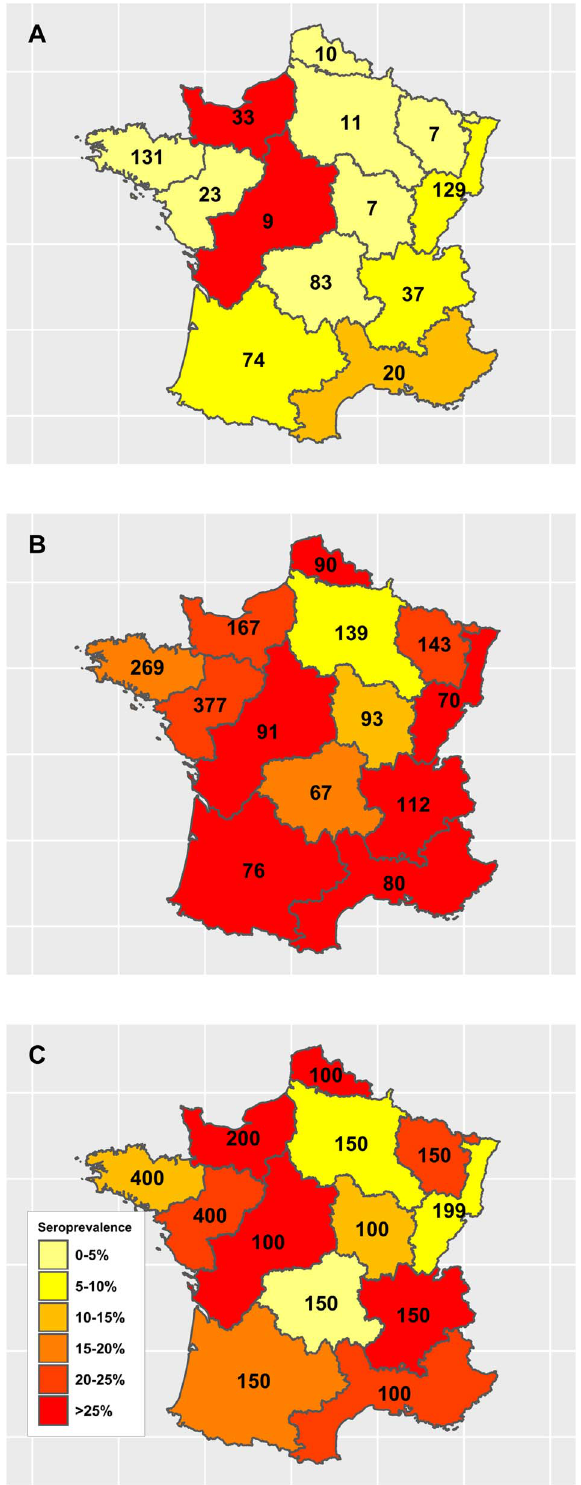
Figure 2. Geographical variation of Toxoplasma gondii seropreva- lence of French bovine samples according to the area of slaughtering and to age categories: (A) calves; (B) adults; (C) bovines overall (calves and adults). The numbers represent the number of samples collected for each